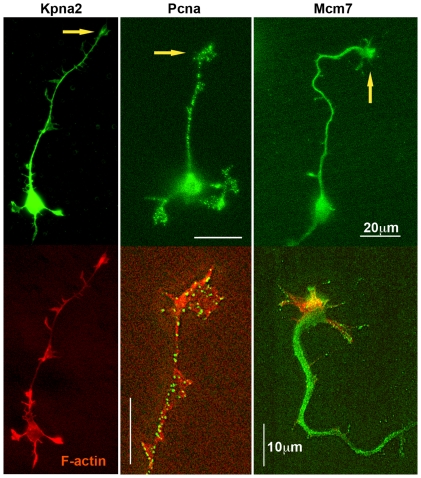
Hippocampal pyramidal neurons and their axonal growth cones labeled with antibodies to proteins involved in functions of the nucleus (top row).The antibody specificities are indicated above. Additional filamentous-actin label is shown in the bottom row. Large arrows, axonal growth cones.